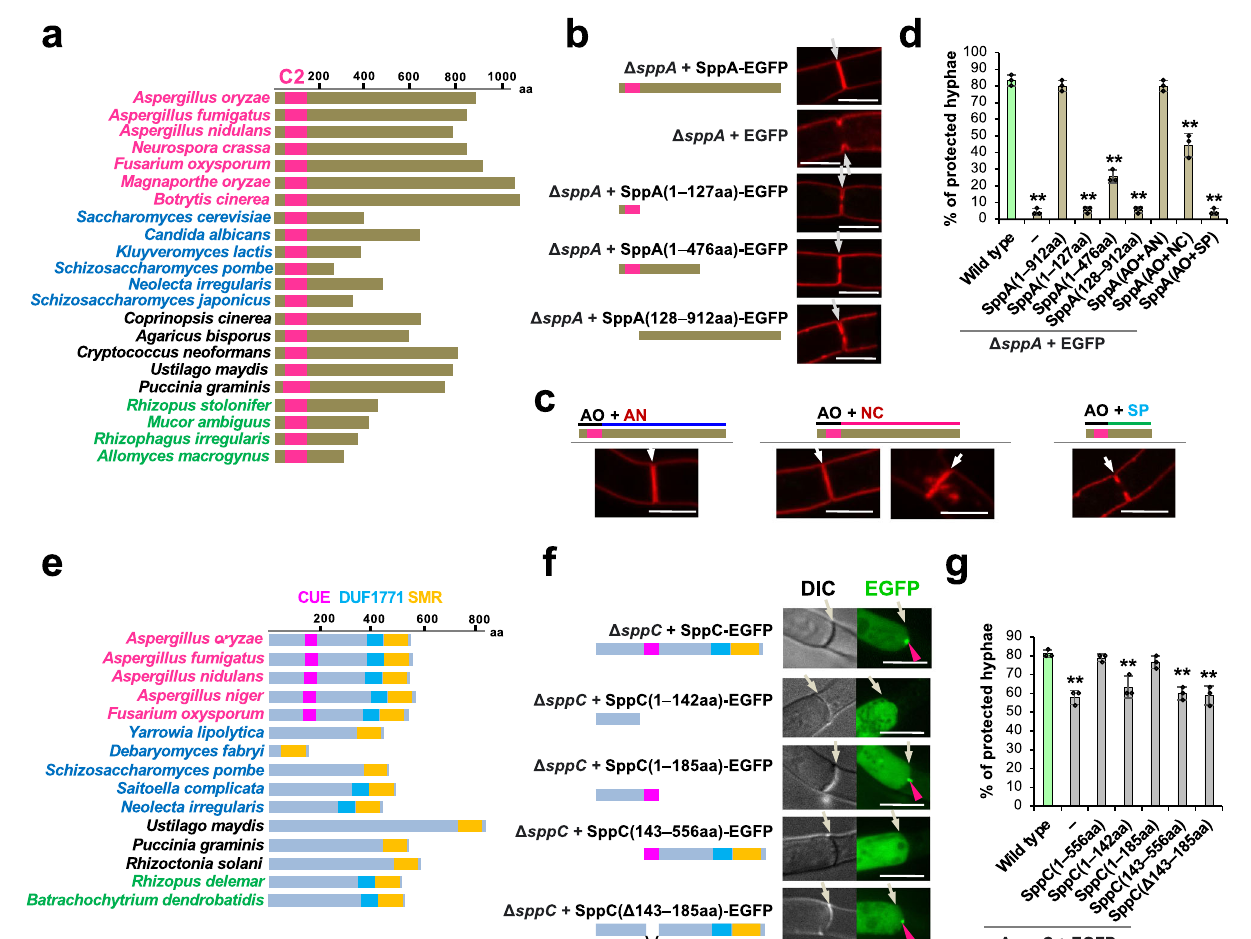
Fig. 8 | Functional dissection of SppA and SppC. a, e Lengths of SppA and SppC with their fungal orthologs. Pink, blue, black, and green texts indicate species in Pezizomycotina, ascomycete yeasts, Basidiomycetes, and early diverging fungi, respectively. Bars represent known protein domains. The numbers of amino acid residues are shown in the scale at the top. b Both N- and extended C-terminal regions of SppA are essential for normal septum formation. Apical septa were visualized using FM4-64 dye. c Septa in strains expressing SppA chimeric proteins with the N-terminus along with the C2 domain derived from A. oryzae and the C-terminus derived from the septal pore-bearing or -lacking ascomycetes. AO Aspergillus oryzae , AN Aspergillus nidulans , NC Neurospora crassa, SP Schizo- saccharomyces pombe . Septa were visualized using FM4-64 dye. SppA(AO+NC) rescuedthedefectivephenotypestoanotableextent,andthetwotypicalimagesof